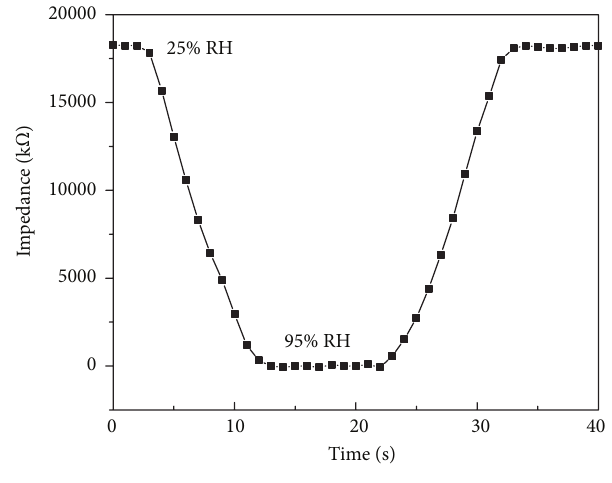
Figure 6: Response and recovery characteristics of 10 mol% La 2 O 3 doped CeO 2 nanopowders sensor measured at 100